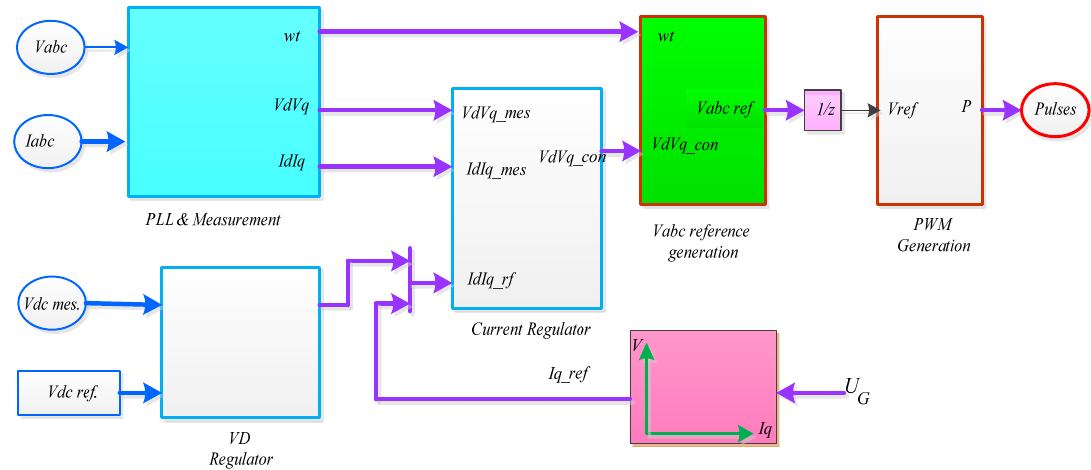
Figure 4. Schematic diagram of the VSI main controller.